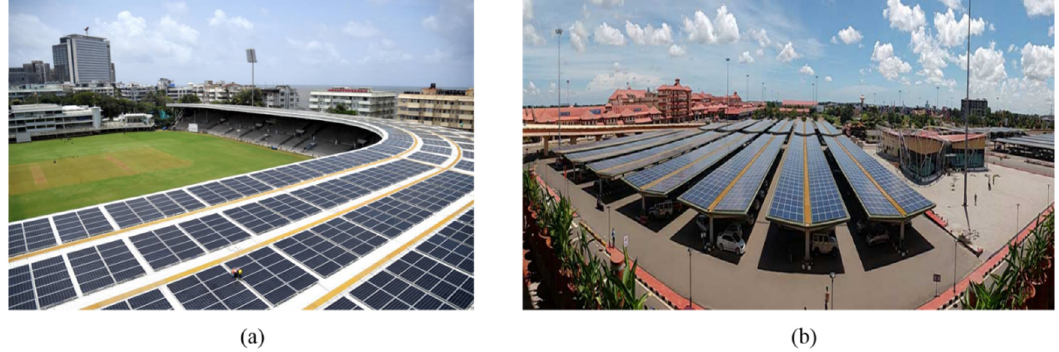
Figure 7. ( a ) World’s largest solar rooftop with a capacity of 820.8 kWp installed on Braboune stadium, at Cricket Club of India, in Mumbai (18.93 ◦ N, 72.82 ◦ E) ( b ) India’s largest solar carport 2.67 Mw at Cochin International Airport (Cial) (10.15 ◦ N, 76.39 ◦ E).